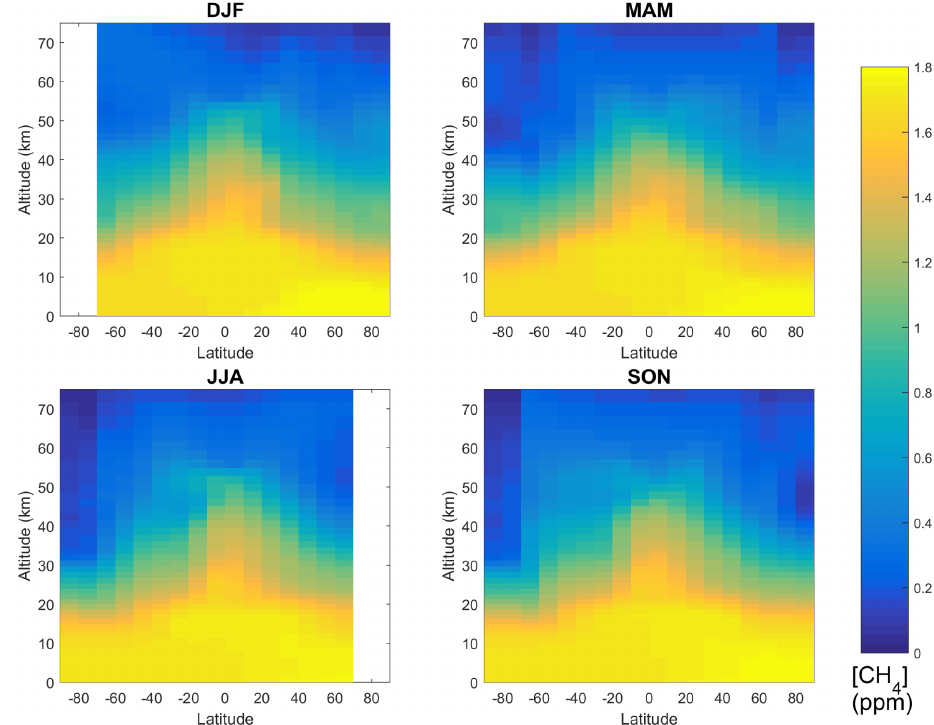
Figure 6. Total methane concentration by season from the ACE-sampled WACCM data set. Especially low levels of CH 4 appear over the South Pole between June and December. In reality, these levels are only present in August and September as shown in the Supplement, but the WACCM sampling method is biased toward those 2 months at those latitudes.